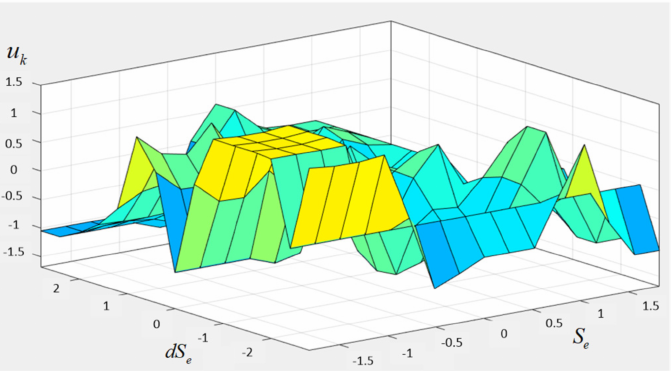
Figure 7. Corresponding relationship of input and output fuzzy sets of fuzzy